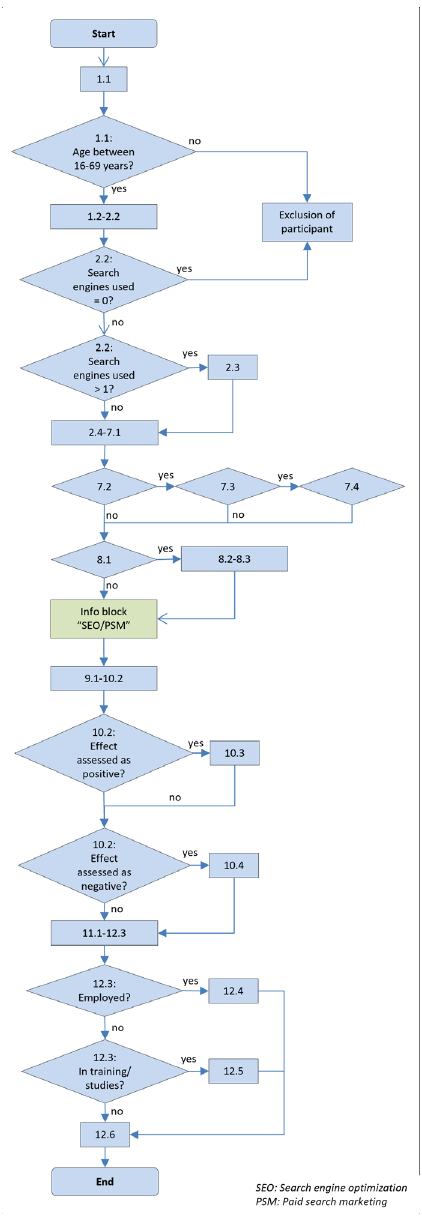
Figure 1. Flowchart of the